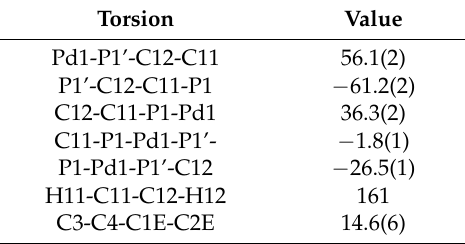
Table 3. Torsion angles ( ◦ ) for [Pd( 6q )Cl 2 ].